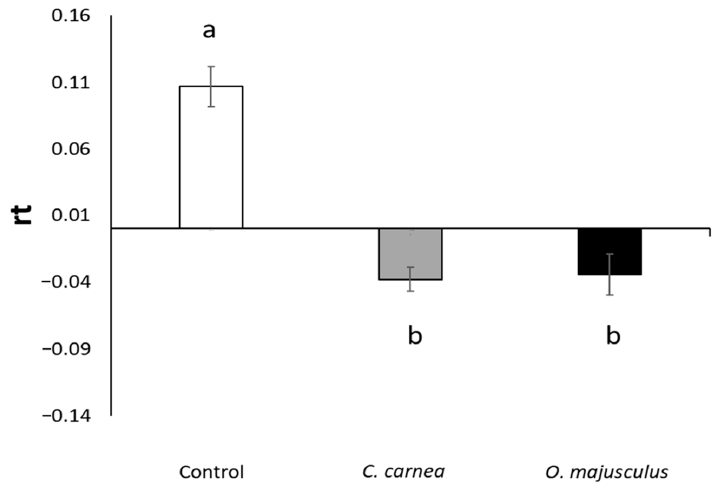
Figure 4. Rate of change of Erasmoneura vulnerata nymph density (mean ± SE) observed in semi-field experiment (2) in the three treatments ( Chrysoperla carnea , Orius majusculus , and Control), two weeks after predator releases. The initial nymph density (about 70 nymphs per cage) was generated by the inoculation of two adult females. Predators were introduced in a ratio of 1/10 E. vulnerata nymphs ( C. carnea ) or 1/30 E. vulnerata nymphs ( O. majusculus ). Data are expressed as rate of change of nymph numbers due to predator introduction. Different letters indicate significant differences at Tukey’s test ( p =